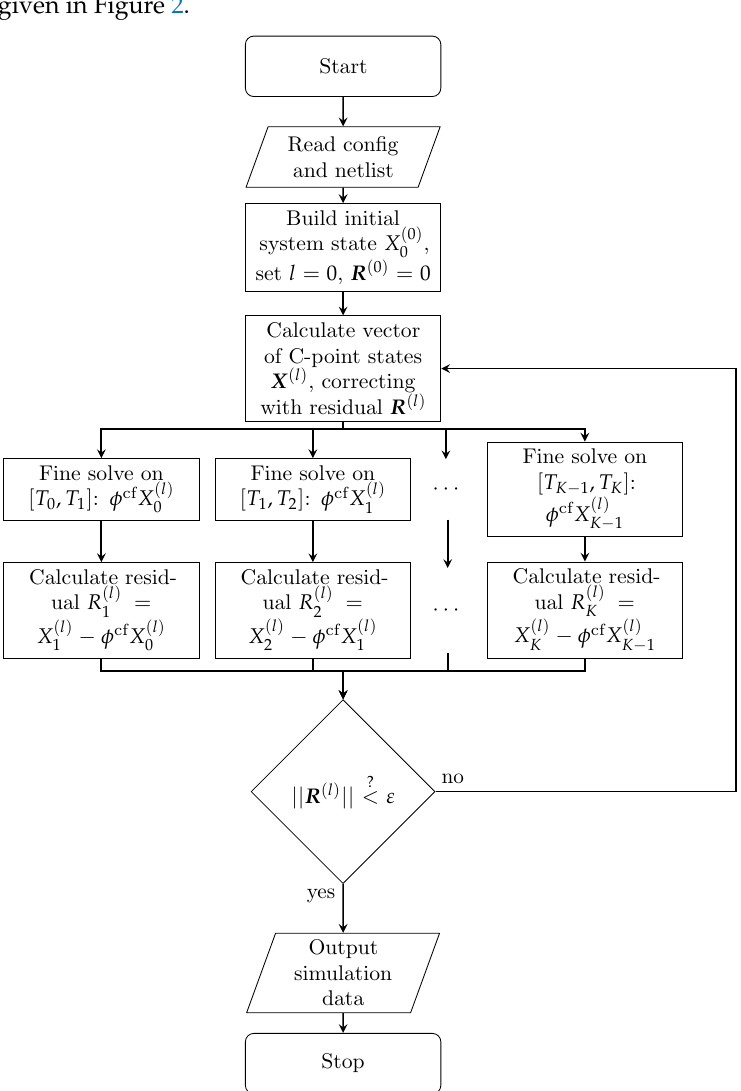
Figure 2. Execution flowchart of the implemented PinT version of the resistive-companion type solver in the 2-level version.